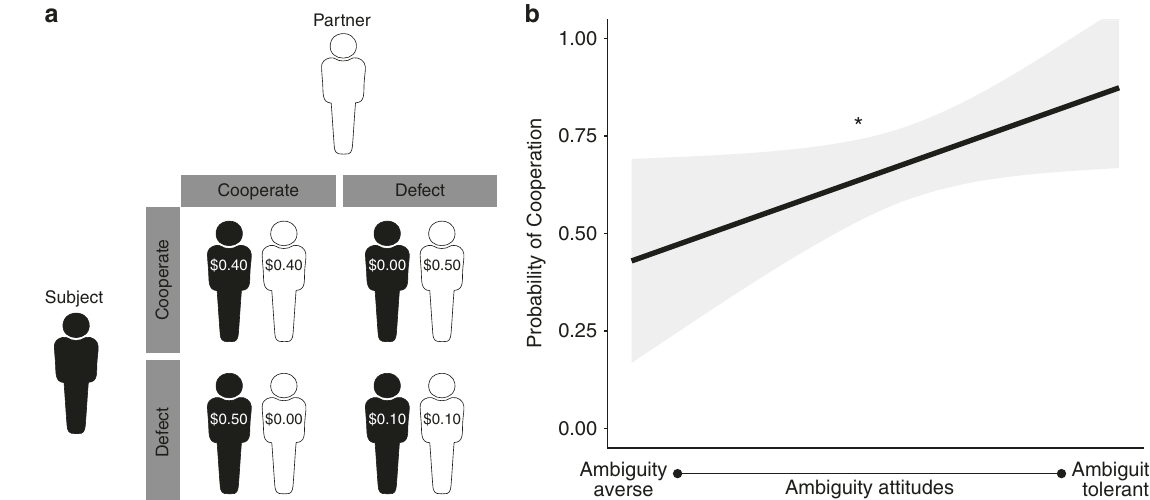
Fig. 4 Experiment 3 task structure and results. a In the prisoner ’ s dilemma, subjects were presented with a matrix of how the payoff structure would work according to their choices and their partner ’ s choices. b A regression reveals decision to cooperate was predicted by greater tolerance to ambiguity. As in experiments 1 and 2, ambiguity attitudes are inverted. Fitted regression lines are plotted. Asterisks indicate signi fi cant differences (* p < .05). Error bars re fl ect 95% CIs Table 4 Experiment 3: Risk and ambiguity attitudes in the prisoner ’ s dilemma DV Coef fi cient ( β ) Estimate (SE) t -value P -value Cooperation